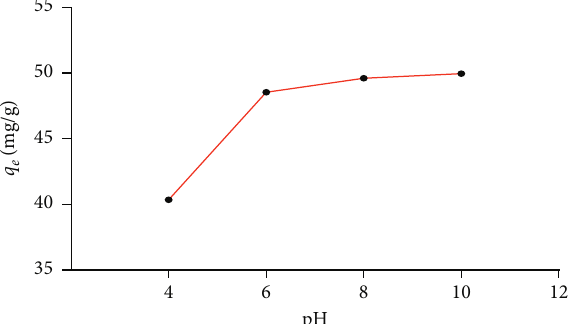
Figure 6: Effect of pH solution in the removal of BG dye. pH range: 4–10, adsorbent amount: 0.2 g, initial dye concentration: 50mg/L, V : 200mL, and T : 25 °